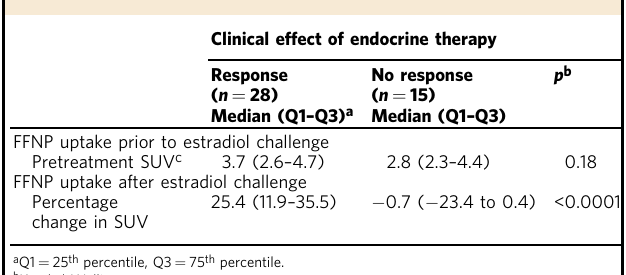
Table 3 Summary of FFNP-PET fi ndings.